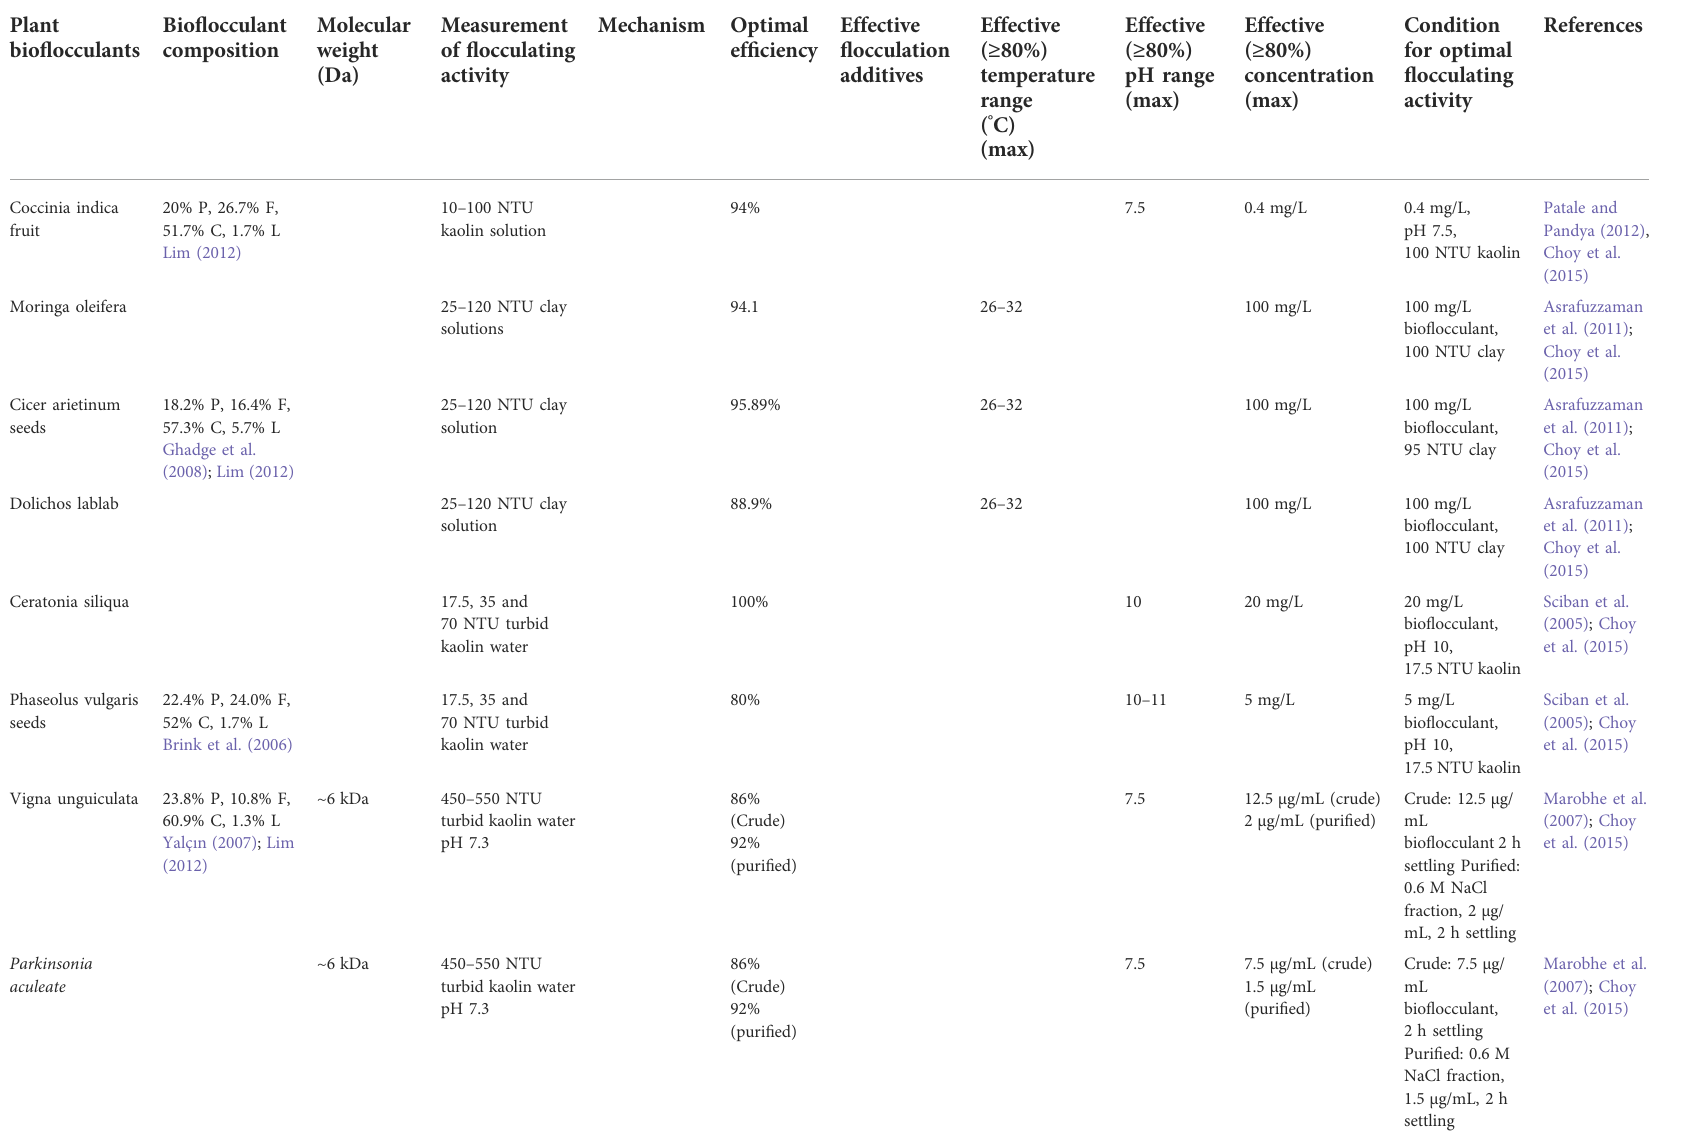
TABLE 4 Plant-derived bio fl